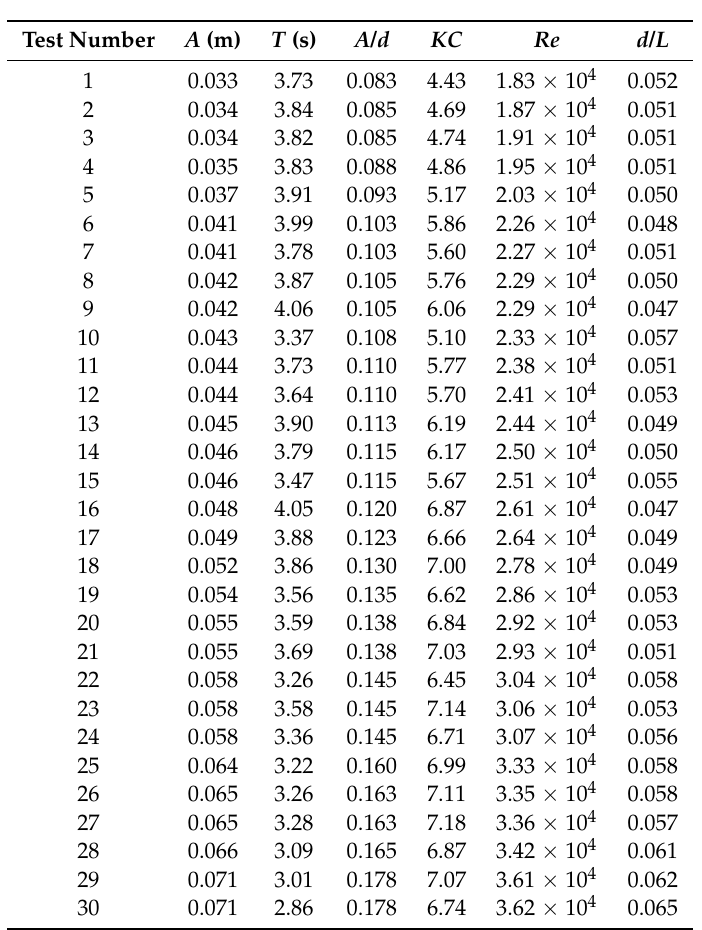
Table 1. Characteristics of the experimental